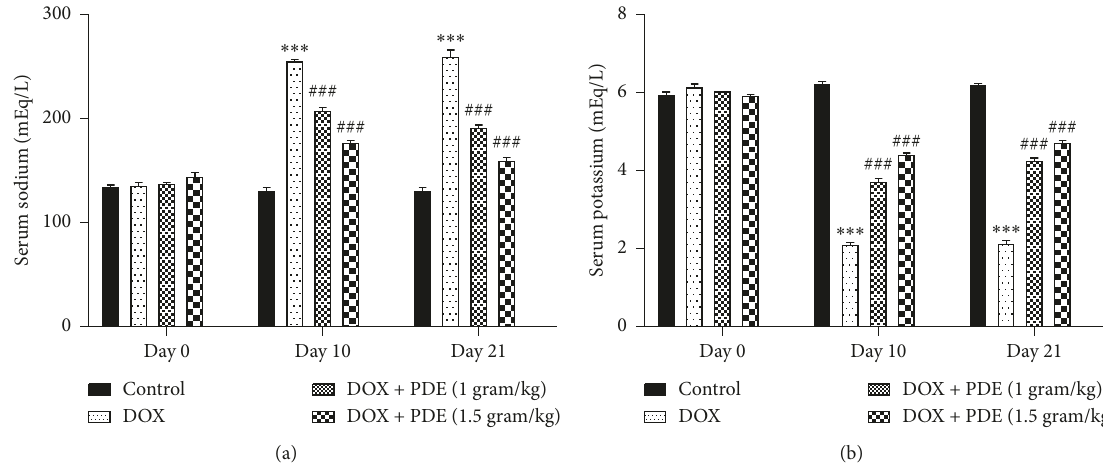
Figure 2: Effects of PDE on serum (a) sodium and (b) potassium levels in DOX-induced changes in rats. The values are mean ± SEM ( n � 6). Statistical analysis was done through two-way analysis of variance (ANOVA) followed by Bonferroni post hoc test. For determination of p values, DOX is compared with the control group, and treatment groups were compared with the DOX group. The results are considered significant if p < 0 . 05. ∗∗∗ p < 0 . 001 vs. control and ### p < 0 . 001 vs. DOX.